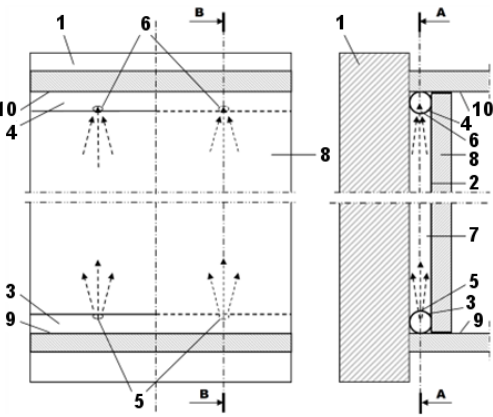
Figure 2. Arrangement of the elements of the blowing and suction